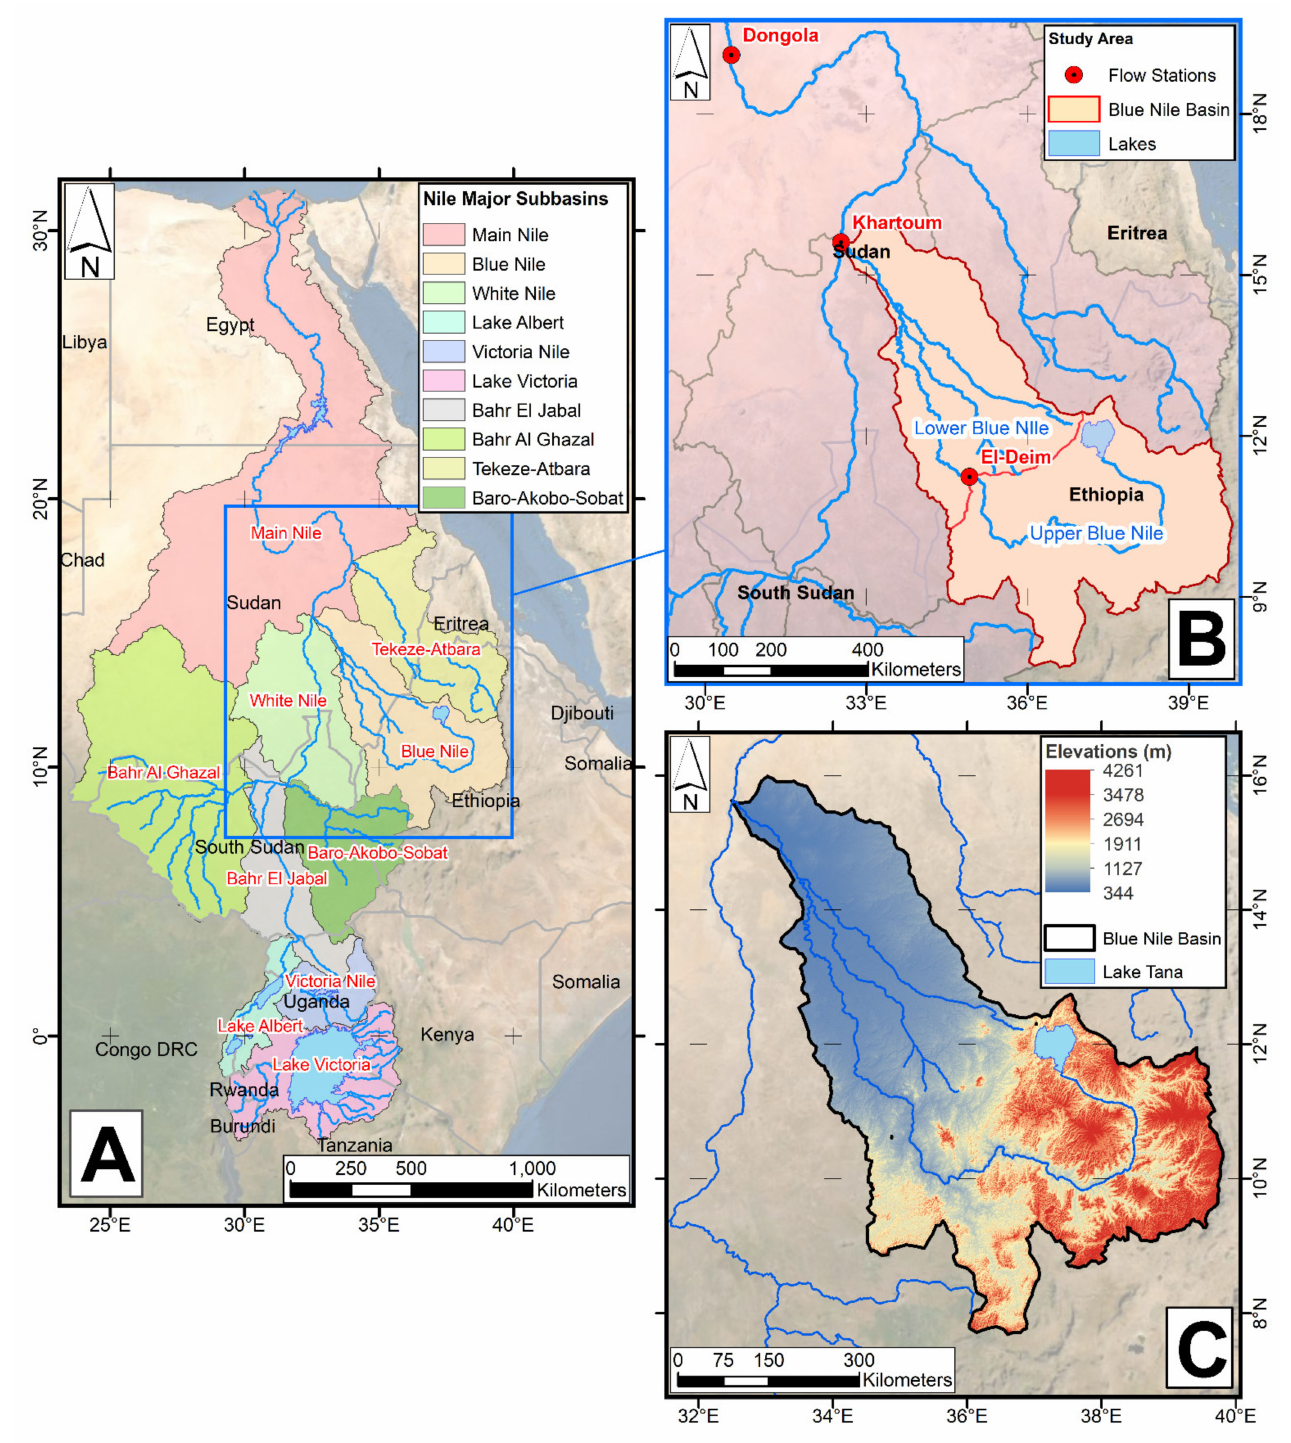
Figure 1. The Nile basin ( A ) The major sub-basins of the Nile River and its countries; ( B ) The Blue Nile basin and the main flow stations of the Blue Nile and at the downstream sub-basin; ( C ) the topography of the Blue Nile